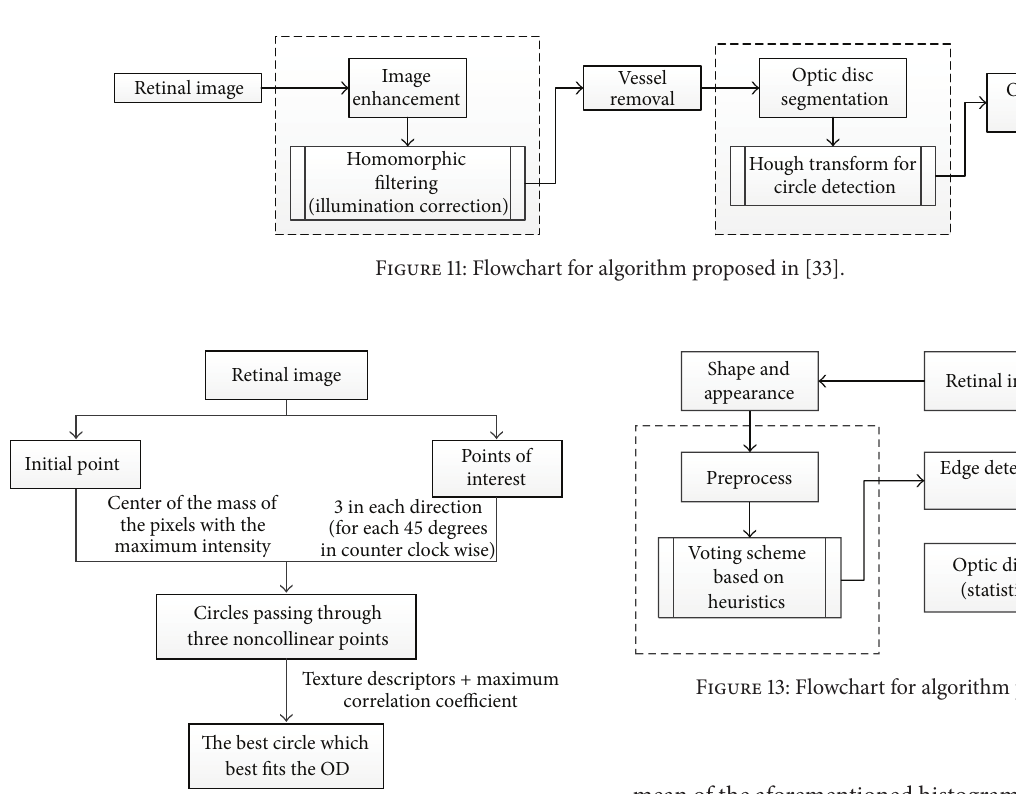
Figure 10: The calculation process of the circular OD boundary approximation. (R) Red channel. (G) Green channel. ((R1) and (G1)) Vessel elimination. ((R2) and (G2)) Gradient magnitude image. ((R3) and (G3)) Binary image. ((R4) and (G4)) Cleaner version of the binary image. ((R5) and (G5)) Circular OD boundary approximation.